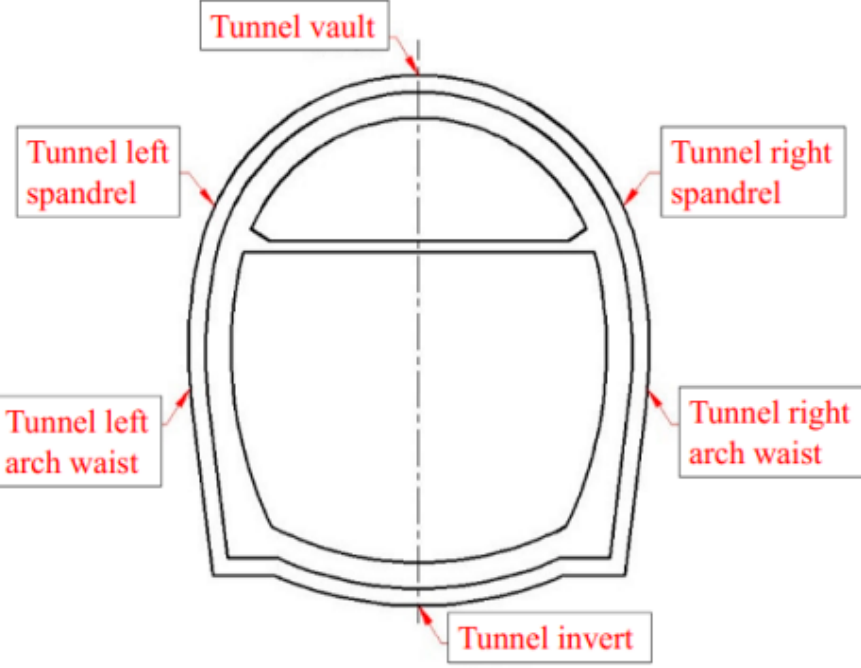
Figure 3. The external water pressure measuring points of initial support.